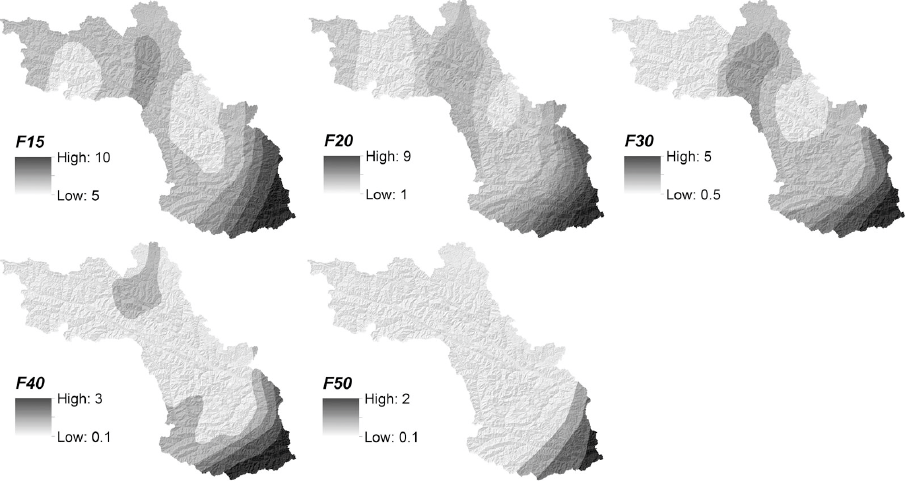
Figure 3. Distribution of factors related to triggering conditions. Finally, a total of 52 factors influencing debris flows were selected and calculated, as shown in Table